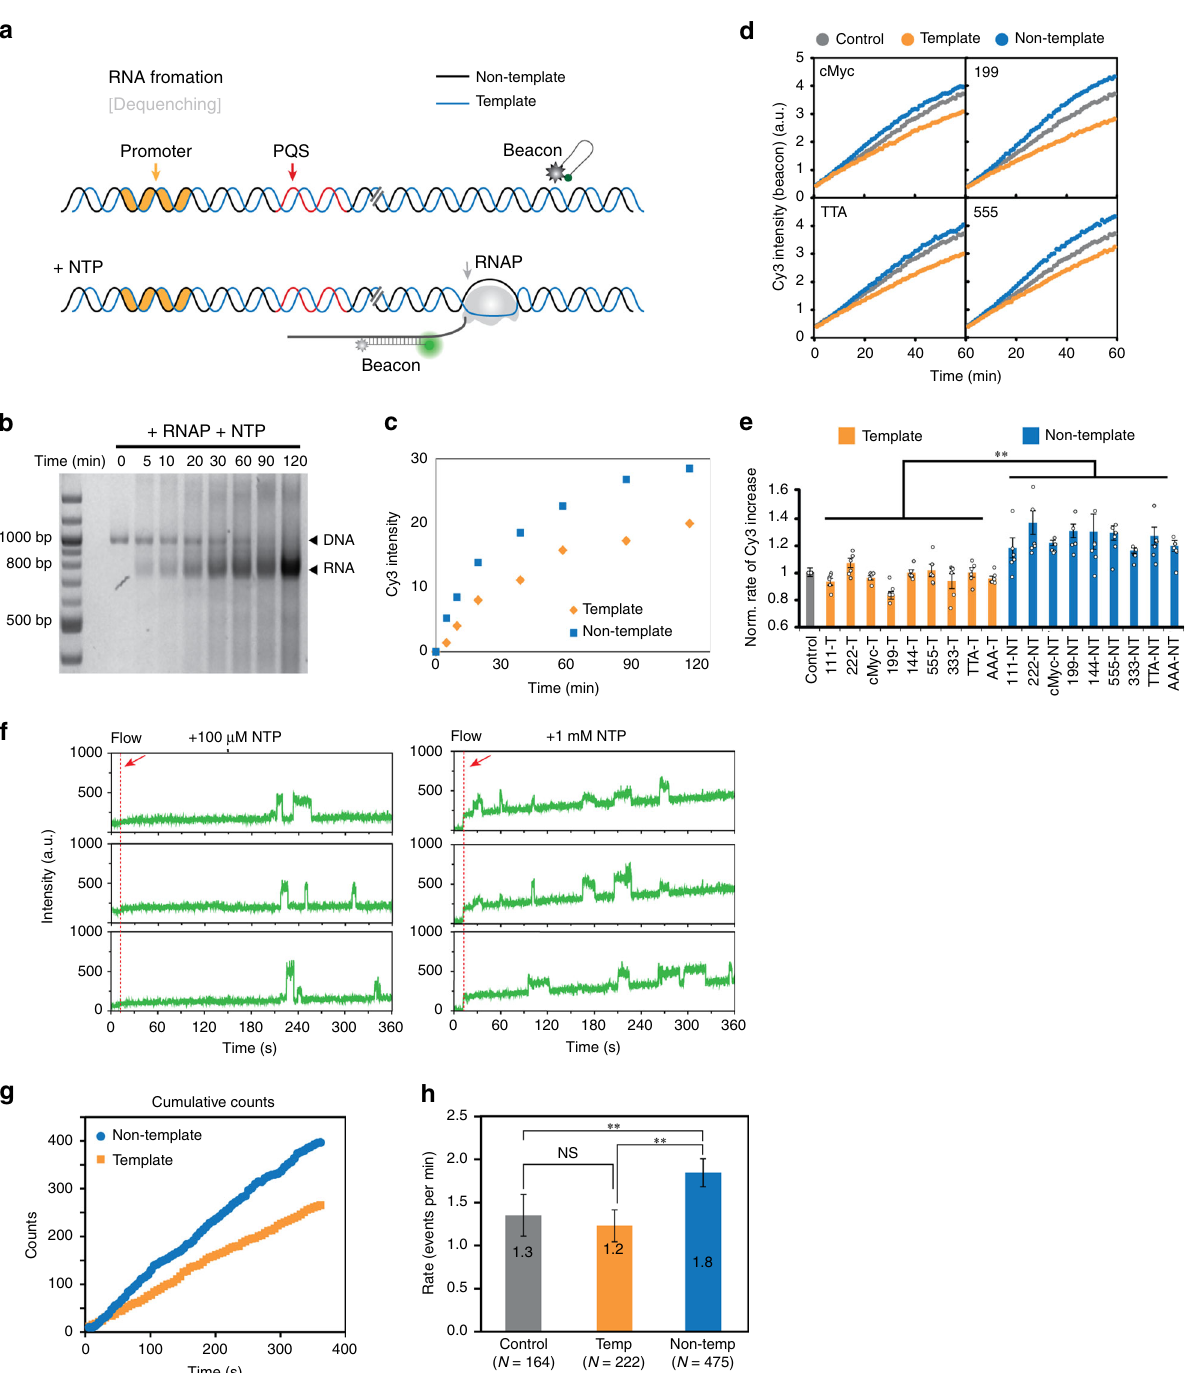
Fig. 1 PQS orientation effect on RNA production detected by molecular beacon in both ensemble and single-molecule transcription assay. a The schematic of beacon assay. Promoter, PQS, and RNAP are colored in orange, red, and gray, respectively. Transcribed RNA is annealed with beacon, dequenching the Cy3 signal. b Transcribed RNA mixed with beacon is distinguished from DNA substrate by 3% agarose gel electrophoresis. Shown is a representative result from two independent experiments of one substrate. c Quanti fi cation of Cy3 intensities from b . d Real-time Cy3 signal measurements of individual PQS samples by plate reader. e Initial RNA production rate is calculated from the early linear part of curve in d . Data are presented as mean ± SEM of n = 6 independent experiments. The exact data and P -values are provided in Supplementary Table 3.1. ** P < 0.005 (two-sided unpaired t -test). Shown in e only represents the signi fi cance between template and non-teamplate. f Single-molecule assay detects Cy3 signal bursting, while annealing with transcribed RNA close to surface. Red arrow indicates the initiation point when RNAP, NTP, and beacon mix is fl own into detection chamber. g Cumulative counts of Cy3 burst from more than 150 traces (as shown in f ). h The frequency of Cy3 bursts calculated from 1 mM NTP measurement (as shown in f ). Data are presented as values ± SEM. N value indicates the number of independent measurements. Statistics is described in “ Methods ” and Supplementary Table 3.2, and the data are provided in Source Data fi le. ** P < 0.01, NS: nonsigni fi cant (one-sided Kruskal – Wallis